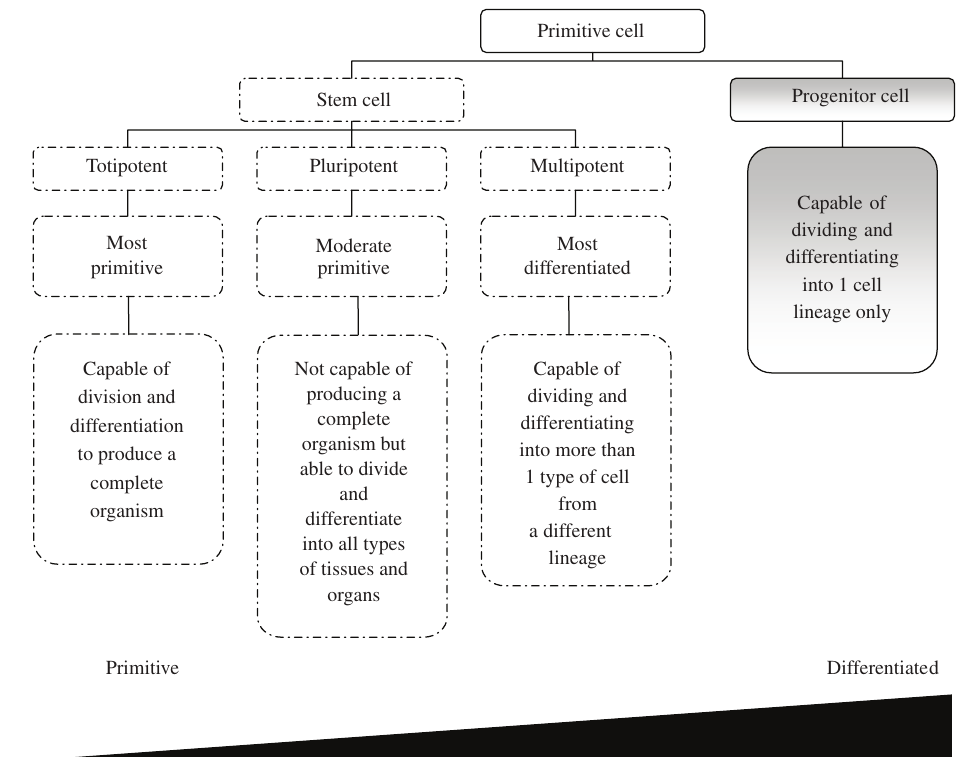
FIGURE 1: Classification of primitive cells. Stem cells are primitive cells that can be classified into three types: totipotent, pluripotent, and multipotent. Each type of cell has distinguishable characteristics. The pro- genitor cell is also a primitive cell, although this cell is the most differentiated cell among the primitive